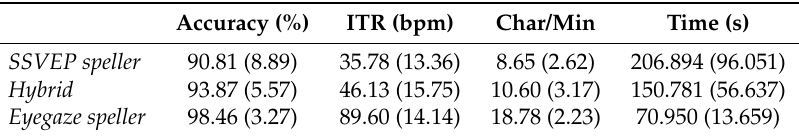
Table 3. Mean (SD) values achieved for the 18 participants who completed the tasks with all three applications: the steady-state visual evoked potentials based application ( SSVEP speller ), the here presented Hybrid application, and the eye tracking based application ( Eyegaze speller ). The presented values are: the overall accuracy, the information transfer rate (ITR), the characters/minute, an the overall time needed to complete the spelling task). Subjects that were not able to successfully control all three spelling interfaces were excluded from the calculation of mean